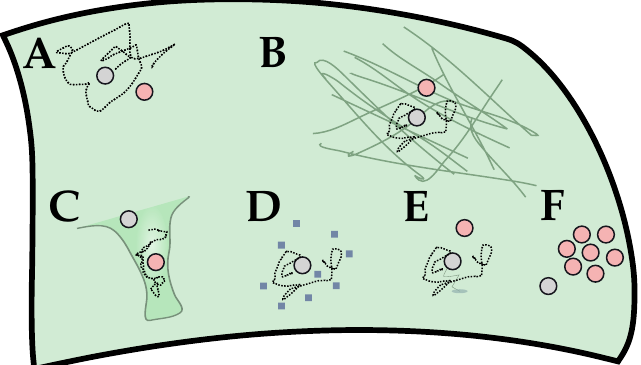
Figure 8. In this perspective, we consider GPCR signaling as a reaction-diffusion process (A). Due to the unavailability of G protein following activation, the diffusive travel times are relevant and can be limiting to the observed reaction rates. From this, local modulation of signaling can be phrased as a local modulation of diffusive properties. We focus on a change in the subplasmalemmal environment (B) through a change in actin expression. This aims to directly modulate the diffusion constant D of the relative motion between GPCR and G protein. Less directly, the distribution of diffusive travel time and, thus, the global reaction kinetics can be affected by a change in geometry (i.e., local curvature (C)). The diffusion constant can also be modulated by other means, with possibilities including membrane composition (D) or GIPs binding to the receptor (E). A less direct way for changing diffusion times would be non-trivial spatial statistics (i.e., clustering or oligomerization (F)). The effect of C and F can be partially captured in the simple model discussed here (see Section 2.3). They also are related to the issue of anomalous diffusion (Section